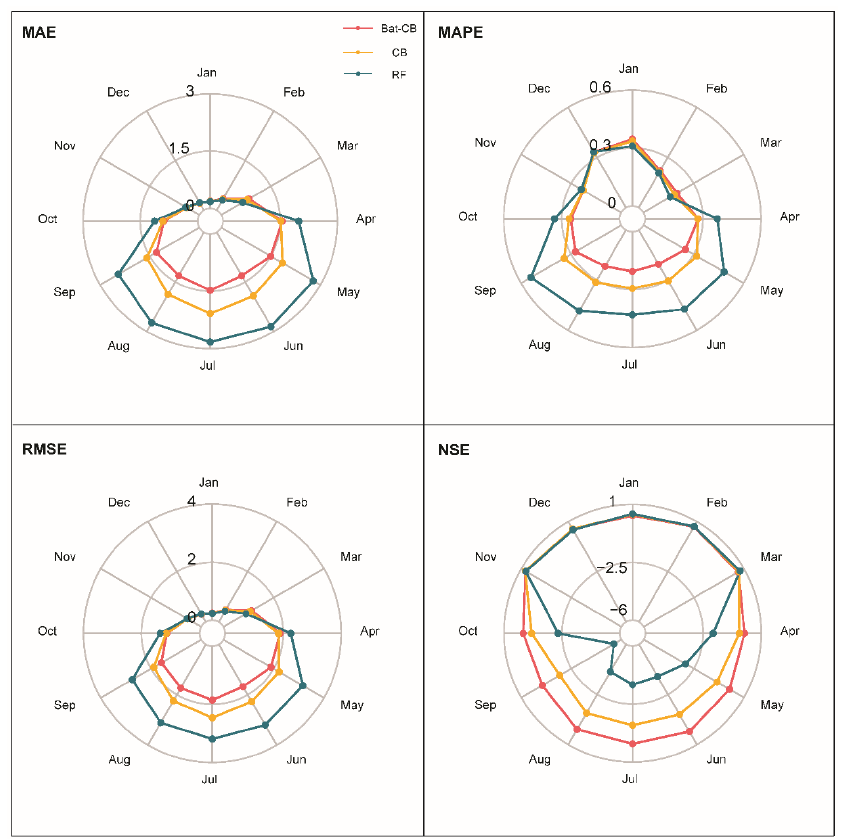
Figure 6. Polar plots showing the monthly average values of the four statistical indicators generated from the three models in forecasting pan evaporation. Table 3. Monthly average values of statistical indicators generated from the three machine learn- ing models during the testing period. Models Indicators